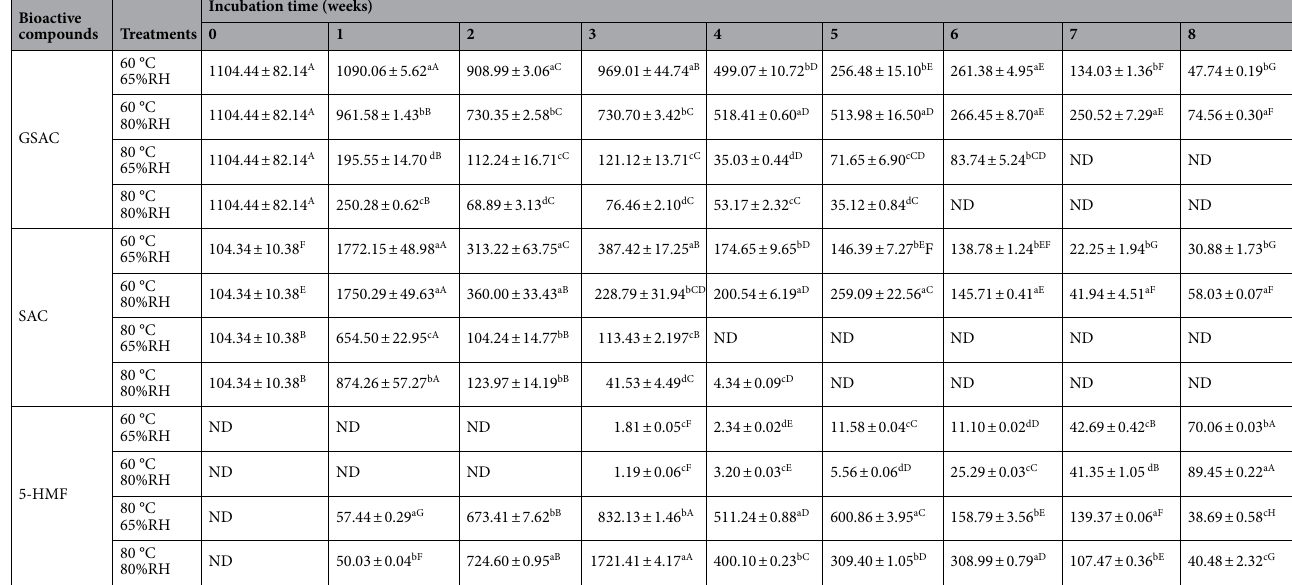
Table 1. Bioactive compounds of black garlic prepared using soaking followed by freezing pre-treatment methods at various temperatures and relative humidities. a–d Different superscripts within the same column indicate significant differences of each colour parameter compared for the same incubation time ( p ≤ 0.05). A–G Different superscripts within the same row indicate significant differences ( p ≤